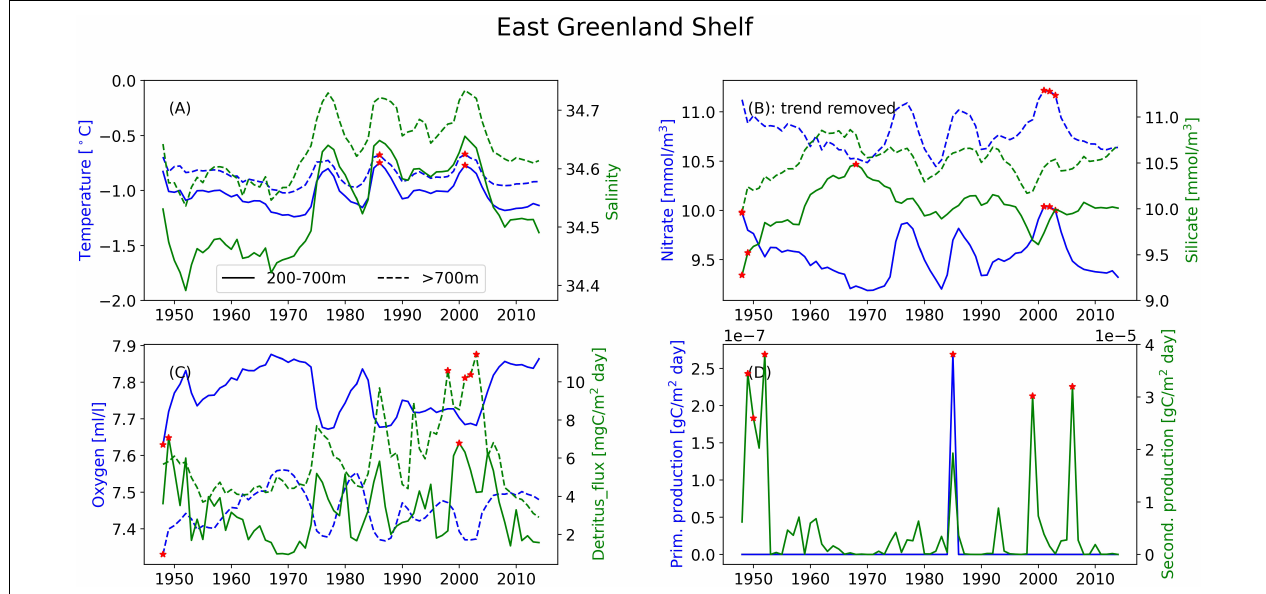
FIGURE 7 | Timeseries of the annual mean of different variables illustrating the interannual variability at the East Greenland Shelf for (A) temperature (blue) and salinity (green), (B) nitrate (blue) and silicate (green), and (C) oxygen (blue) and detritus (green). Solid lines are areas with bottom depth between 200 and 700 m, dashed lines are areas deeper than 700 m. (D) Depth-integrated primary production (blue) and secondary production (green) from the full area. Red stars indicate years when values are outside two standard deviations of the temporal mean.